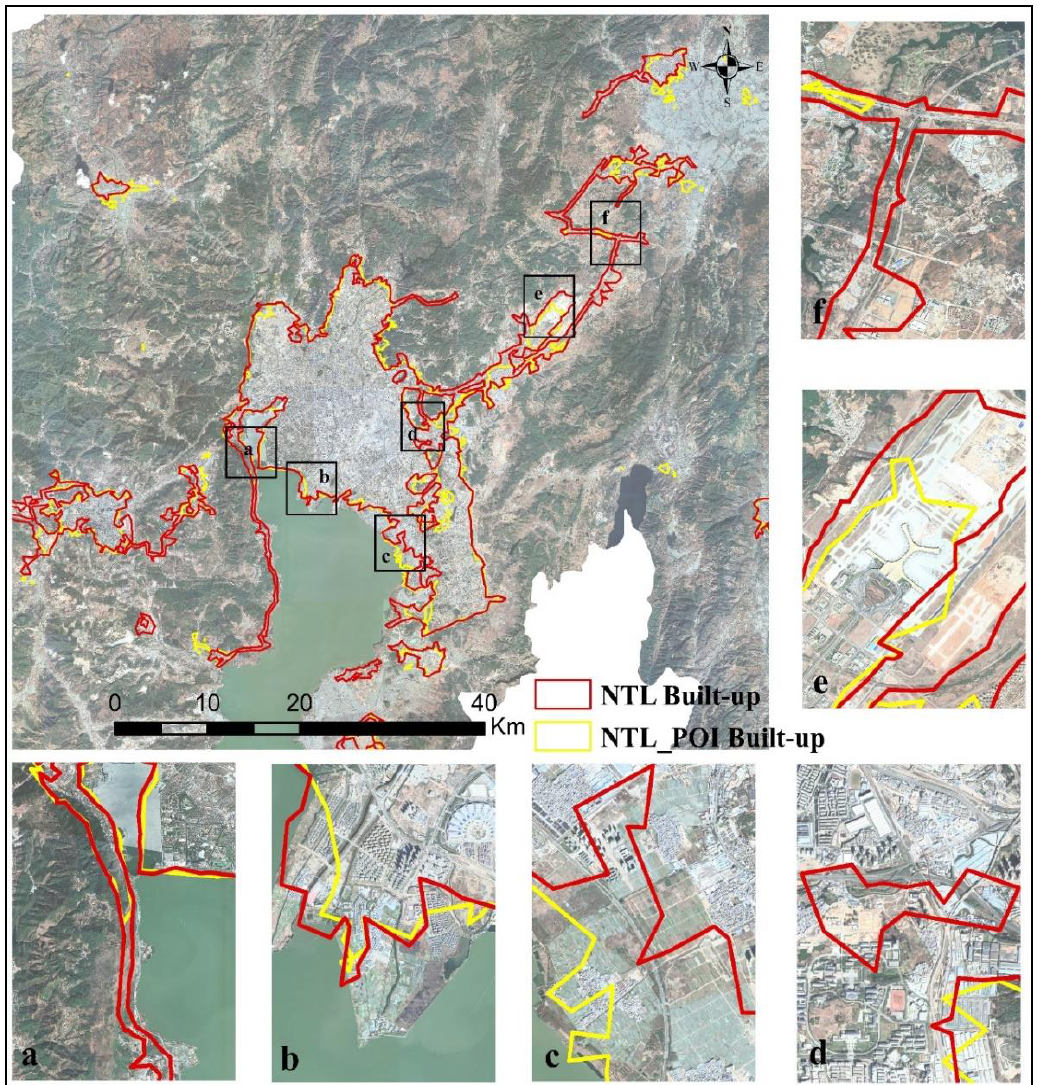
Figure 13. Comparison of urban built-up areas identified by NTL and NTL_POI.